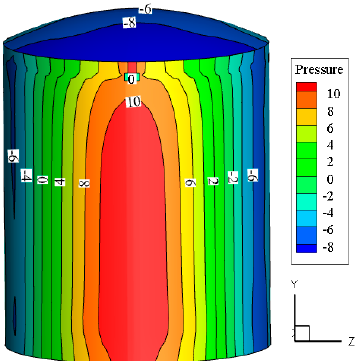
Figure 12. Pressure-cloud diagram for the windward side of the tank wall (Pa).